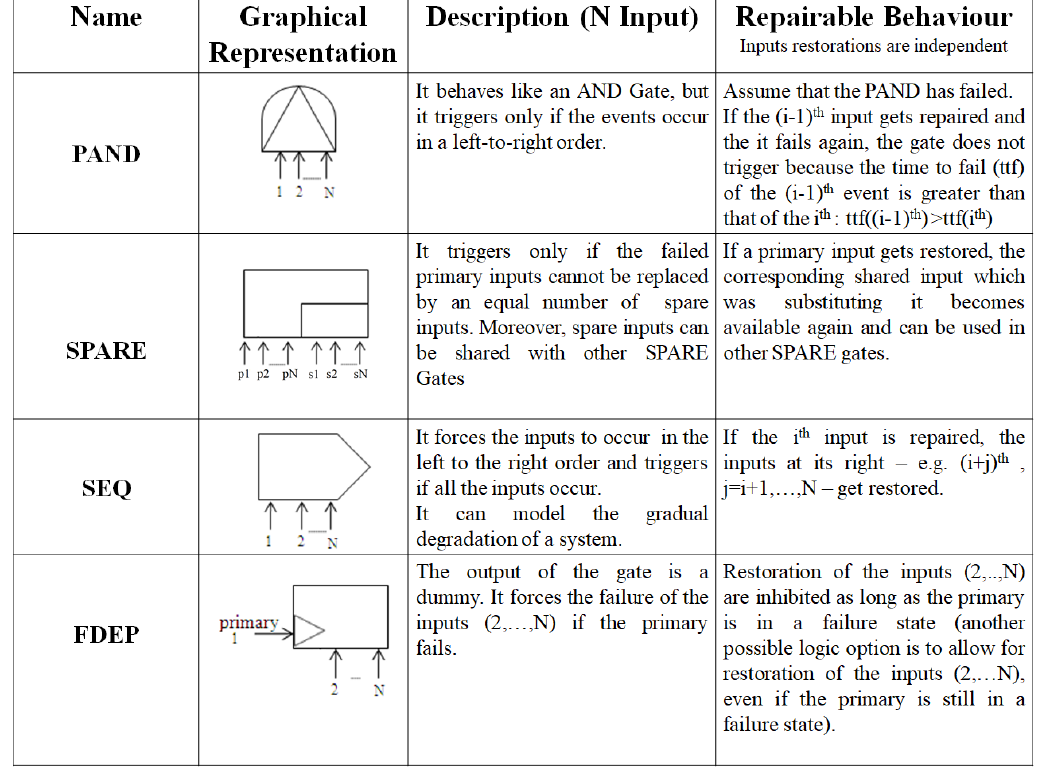
Figure A2. Dynamic Fault Tree gate behaviour.